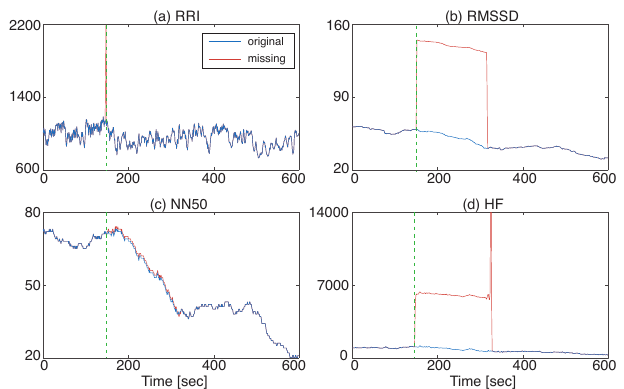
Figure 2. Missing RRI data and its effect on HRV features: ( a ) RRI, ( b ) RMSSD, ( c ) NN50, and ( d ) HF. The HRV features greatly fluctuate when the R detection error